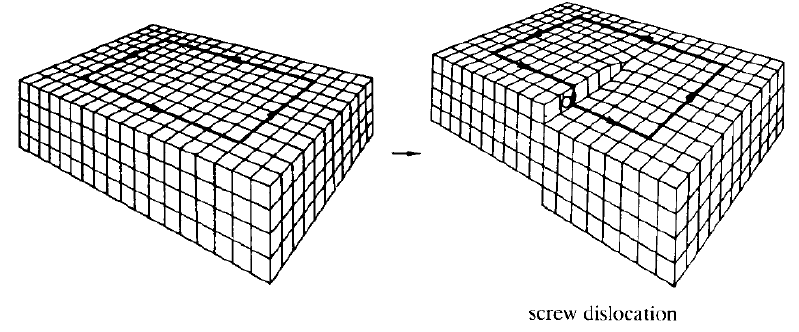
Figure 2. Volterra process for the screw dislocation (taken from [45]). In the picture, the Burgers vector is one lattice spacing long and points